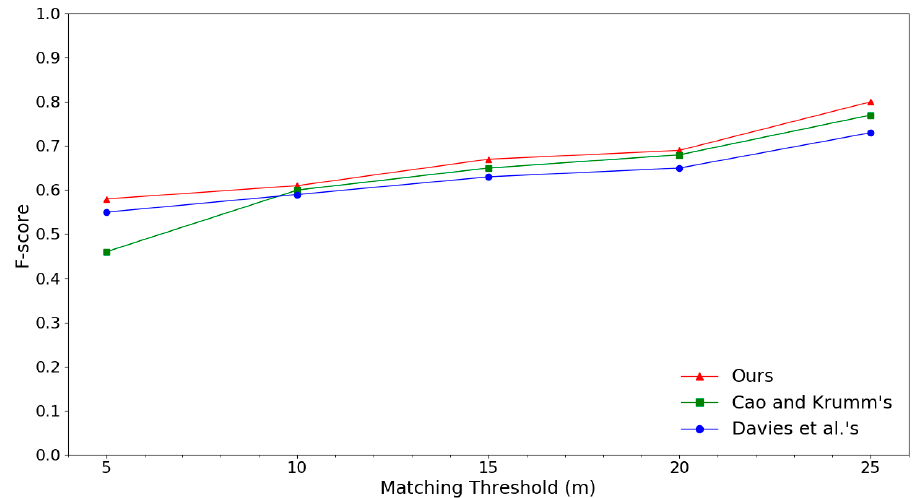
Figure 9. Comparison of the F-scores of our method vs existing methods using different matching thresholds during geometry sampling.